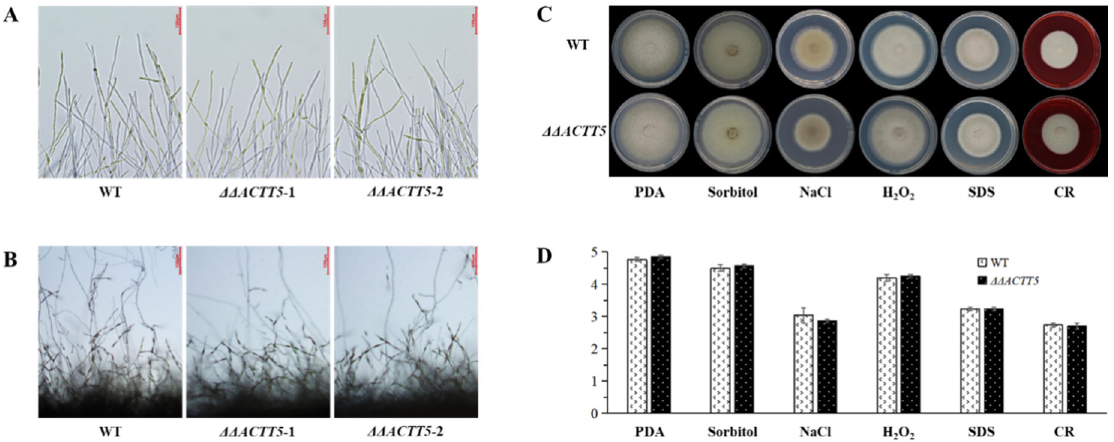
Figure 3. ACTT5 is not involved in conidiation, vegetative growth, and multi ‐ stress resistance. ( A ) Microscopic observation of mycelium of wild ‐ type (WT) and ∆∆ ACTT5 . ( B ) Conidiation of wild ‐ type and ∆∆ ACTT5 . ( C ) Multi ‐ stress analysis of wild ‐ type and ∆∆ ACTT5 . ( D ) The percentage of growth reduction determined by comparing a cumulative percentage of the growth of Z7 and ∆∆ ACTT5 grown on same medium is also shown.